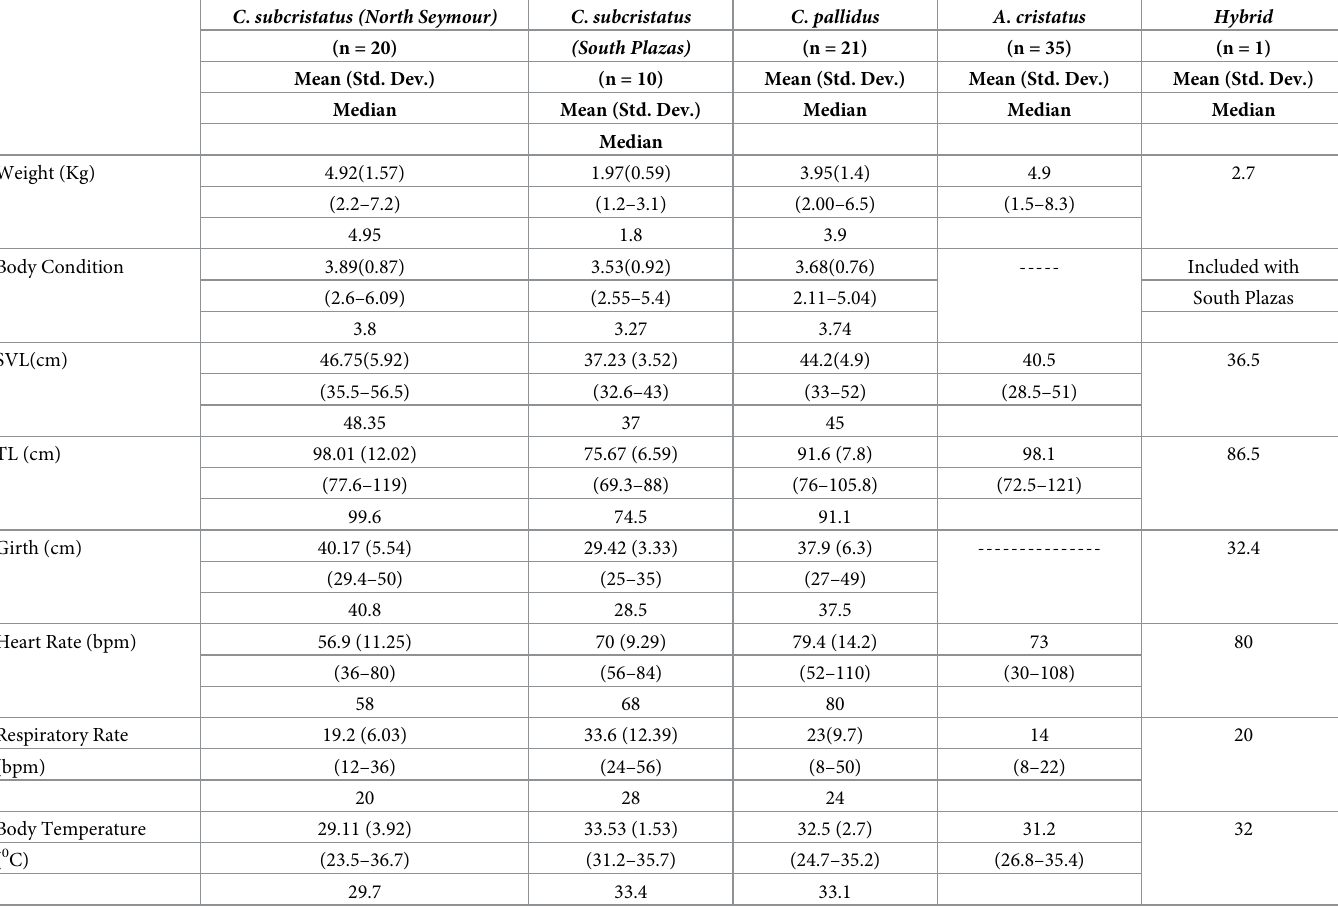
Table 1. Mean, standard deviation, and range of morphometric and vital health parameters for wild Gala´pagos land iguanas with data included on marine iguanas